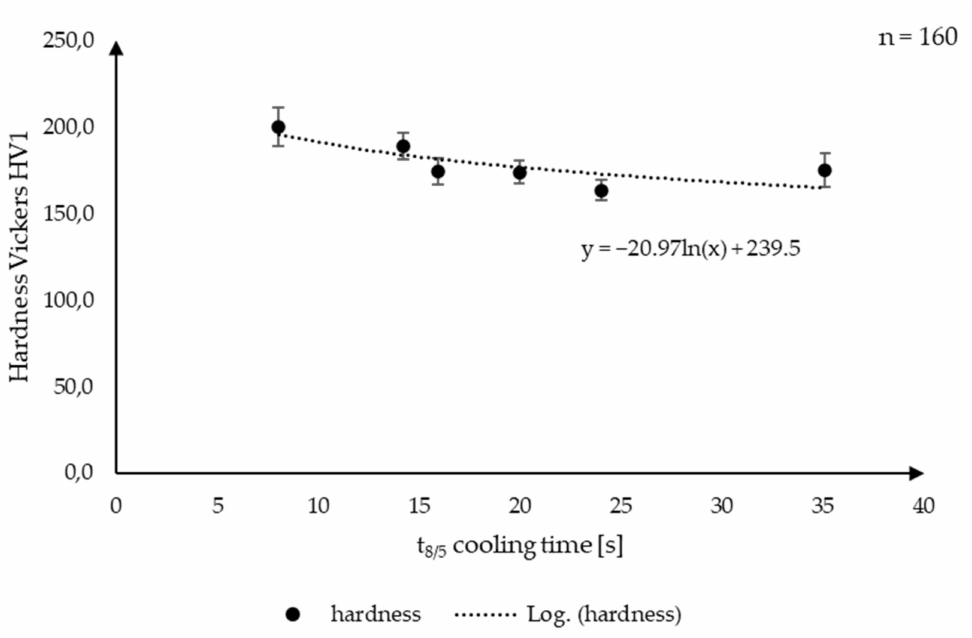
Figure 9. Hardness as a function of t 8/5 cooling time from measured data.